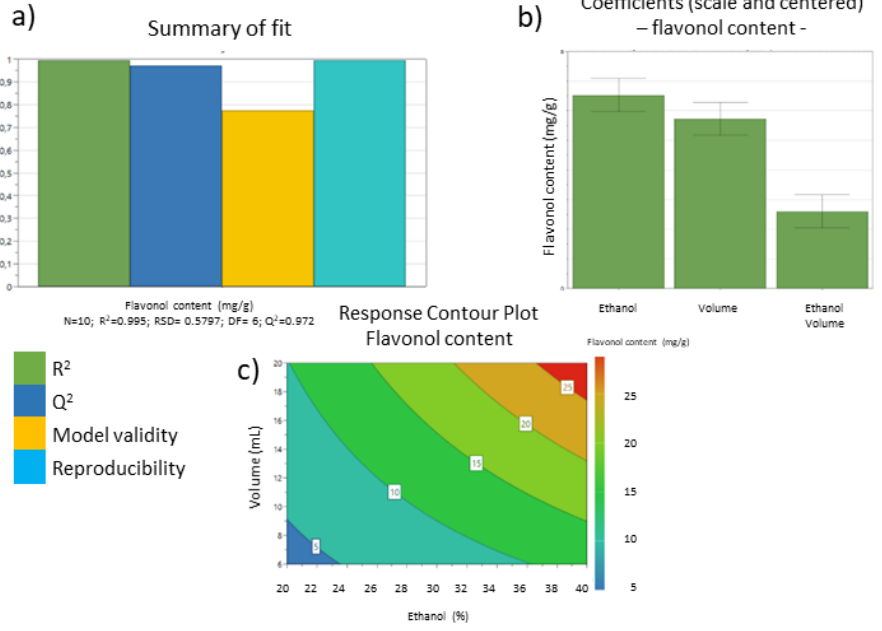
Figure 2. Optimization of tunic A. cepa extraction method using DoE. Summary of fit plots ( a ), regression coefficients of the developed model ( b ), and surface response plot ( c ).